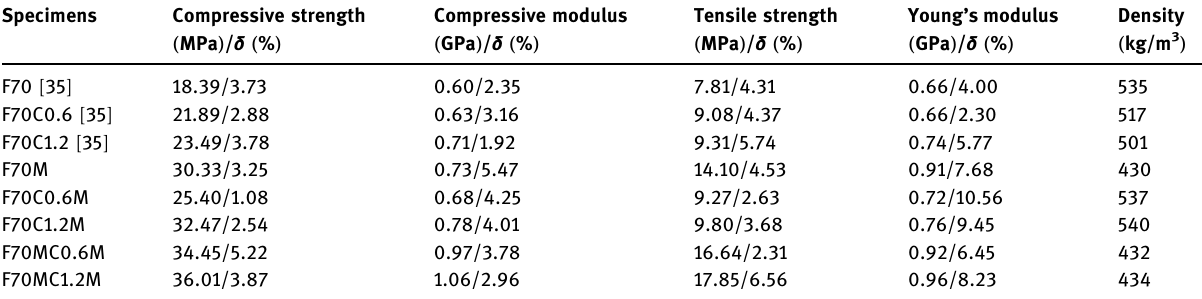
Table 1: Static properties of syntactic foam composites Specimens